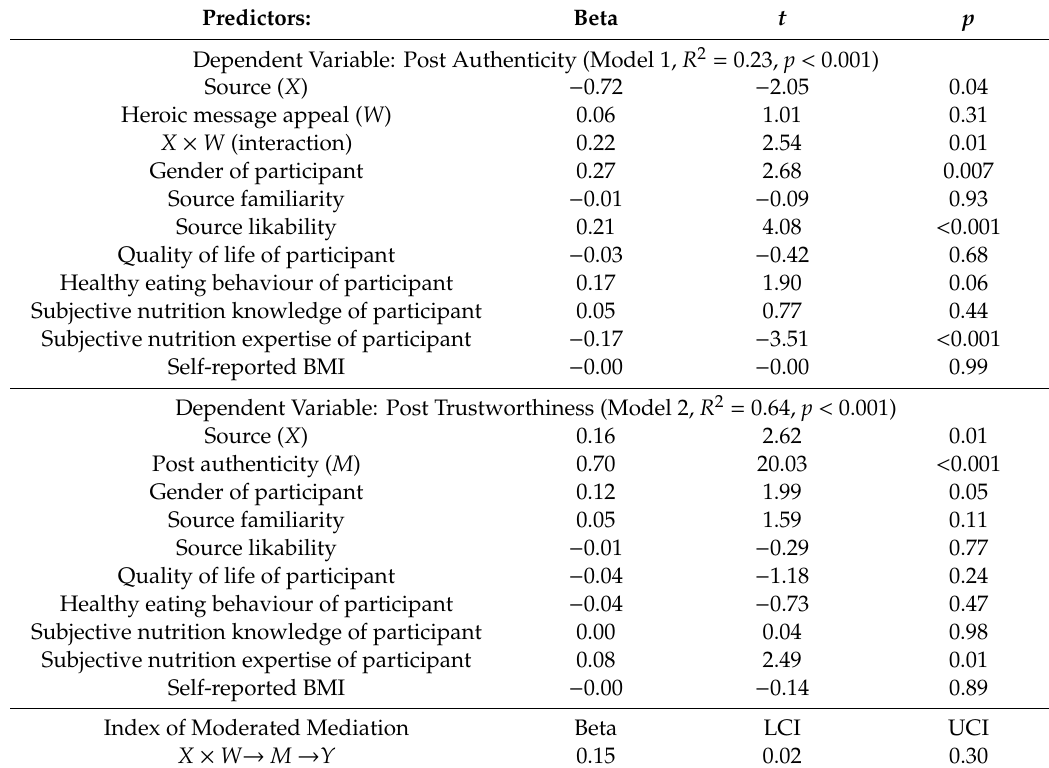
Table 5. Regression Results from PROCESS Model 7. Two models were developed; Model 1: post authenticity, Model 2: post